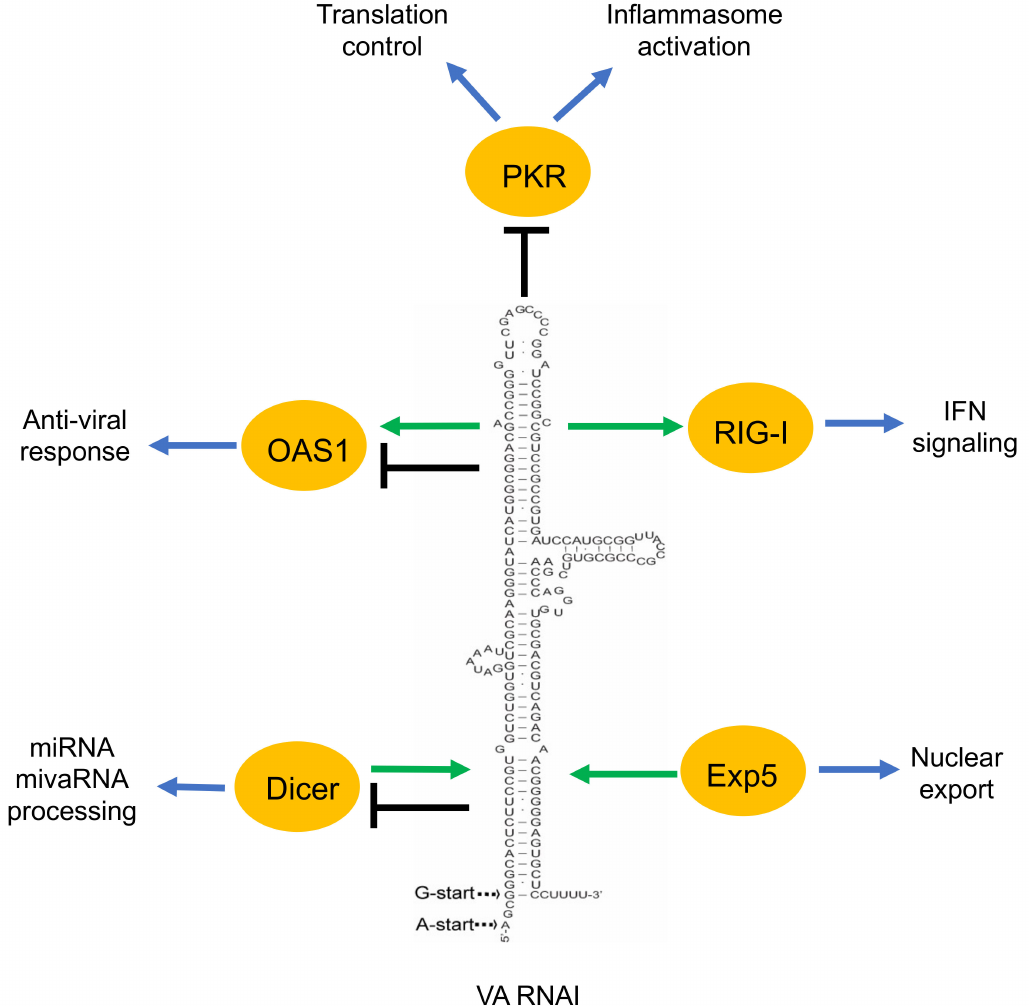
Figure 2. A simplified overview of the VA RNAI functions described in the text. Green arrow indicates the positive e ff ect of VA RNAI to its interacting proteins (OAS1, RIG-I). Moreover, the positive e ff ect of the proteins (Dicer, Exp5) on VA RNAI is shown by a green arrow. Black terminated line indicates the negative e ff ect of VA RNAI on its associating proteins. VA RNAI has a dual e ff ect on some of the proteins (OAS1,